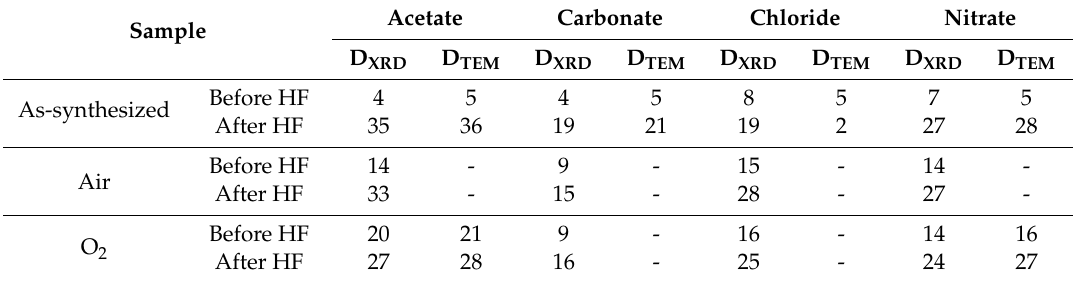
Figure 3. TEM of MgF 2 nanoparticles prepared from acetate ( a ), carbonate ( b ), chloride ( c ) and nitrate ( d ) magnesium precursors. Table 4. Impacts of the precursors and of the treatments in air and in O 2 on the MgF 2 nanoparticle diameters, determined by XRPD (D XRD , nm) and TEM (D TEM , nm), before and after HF